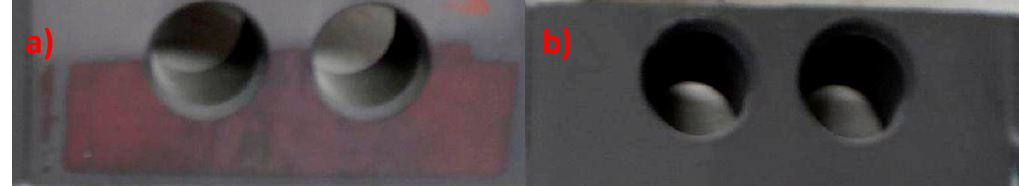
Figure 6. Samples produced under industrial conditions: ( a ) from the phosphating bath with an addition of molybdenum compound; ( b ) in a bath without the molybdenum compound. The samples were produced under the same temperature conditions.